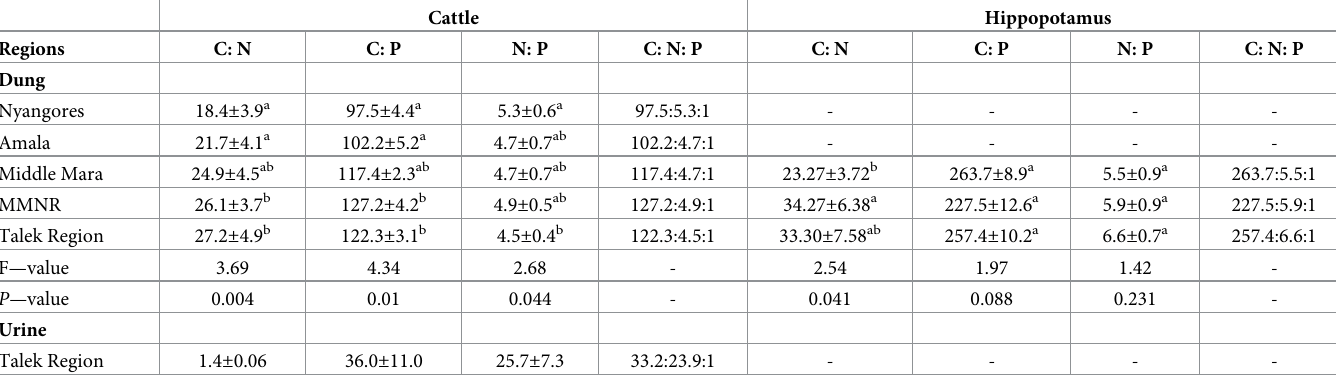
Table 3. Mean ( ± SD ) quality (C: N: P ratio) of cattle dung and urine and hippo dung in different regions in the Mara River basin, Kenya.